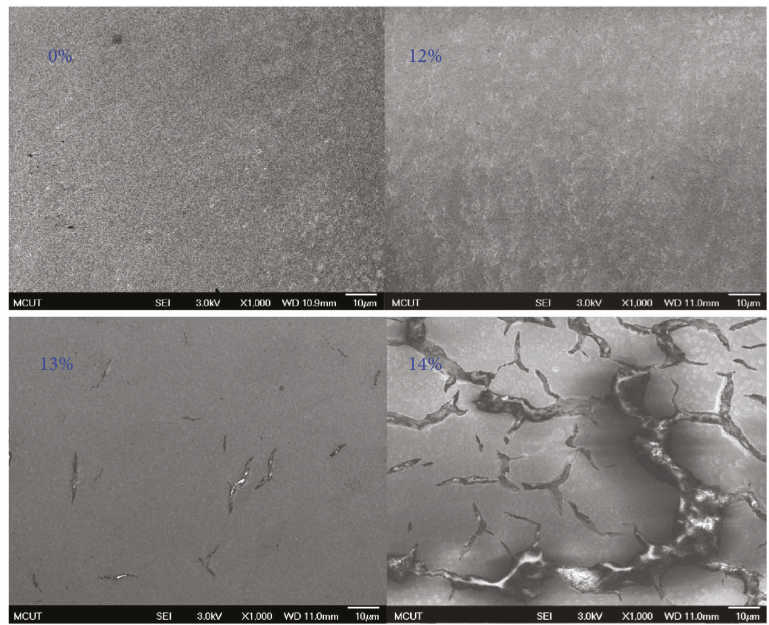
Figure 3: Surface morphology of silver fi lm at various torque forces.